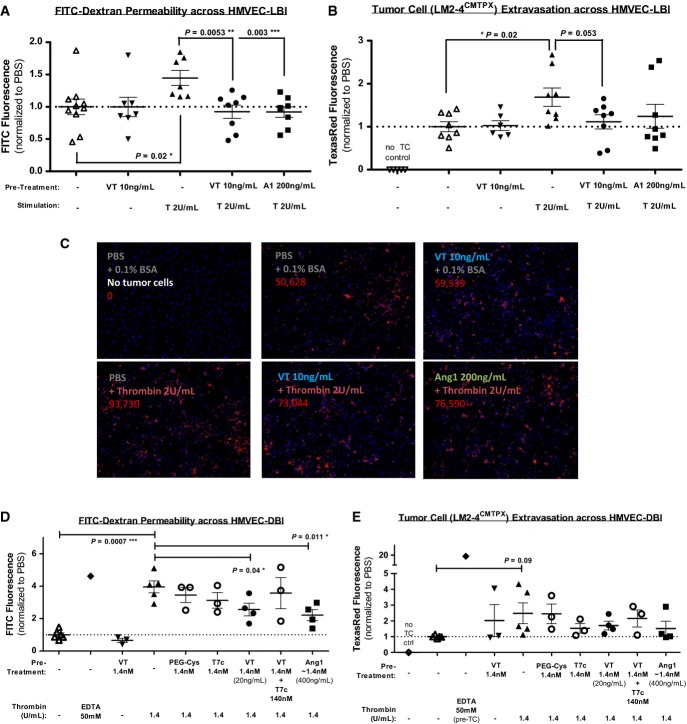
Vasculotide and Ang1 treatments counteract thrombin induction of trans-endothelium macromolecular permeability and tumor cell migration in vitro

A–E Microvascular leak and tumor cell extravasation were modeled in vitro using modified Boyden chamber experiments where lung HMVECs (A–C) and dermal HMVECs (D–E) were grown to 100% confluence over 8-μm-pore insert membranes. ECs were first treated with Vasculotide (VT), PBS (vehicle/negative control), Ang1 (positive control), PEG-Cys (polyethylene glycol backbone), T7c (non-PEGylated CHHHRHSF peptides), or VT in the presence of 100-fold molar excess of T7c. The concentrations used, 10–20 ng/mL VT and 200–400 ng/mL Ang1, are estimated molar equivalents (0.71–1.43 nM). Thirty minutes later, ECs were stimulated with thrombin, 0.1% BSA (vehicle/negative control), or EDTA (positive control). Another 30mins later, the amount of FITC-dextran diffusion into the lower chambers (A, D) provides a measure of endothelial permeability. CMTPX-labeled tumor cells (TCs) were then dispensed into inserts, and the amount of TC fluorescence emitting from the underside of insert membranes after 20 h (B–C) or 28 h (E) reflects the efficiency of trans-endothelial TC migration. Representative fluorescent images (10×) of membrane undersides are shown in (C), where DAPI-stained nuclei of ECs/TCs are shown in blue, ‘extravasated’ CMTPX-labeled TCs are shown in red, and the # of CMTPX+ pixels are shown numerically in red. Means ± SEM are shown (A,B,D,E). Three experiments (twice with HMVEC-LBl and once with HMVEC-DBl) were run with n = 3–5 inserts (independent biological replicates) per group and analyzed by two-sampled unpaired t-tests.